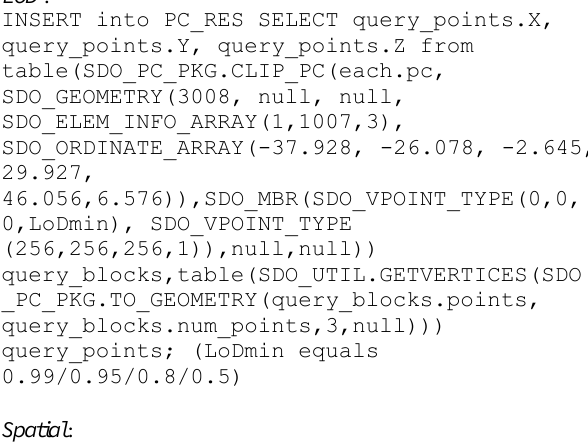
Table with a spatial index : CREATE TABLE S3DISGEOM (Point_geom SDO_GEOMETRY, R number, G number, B number, RoomType number, RoomID number, Class number, ObjectID number, LoD